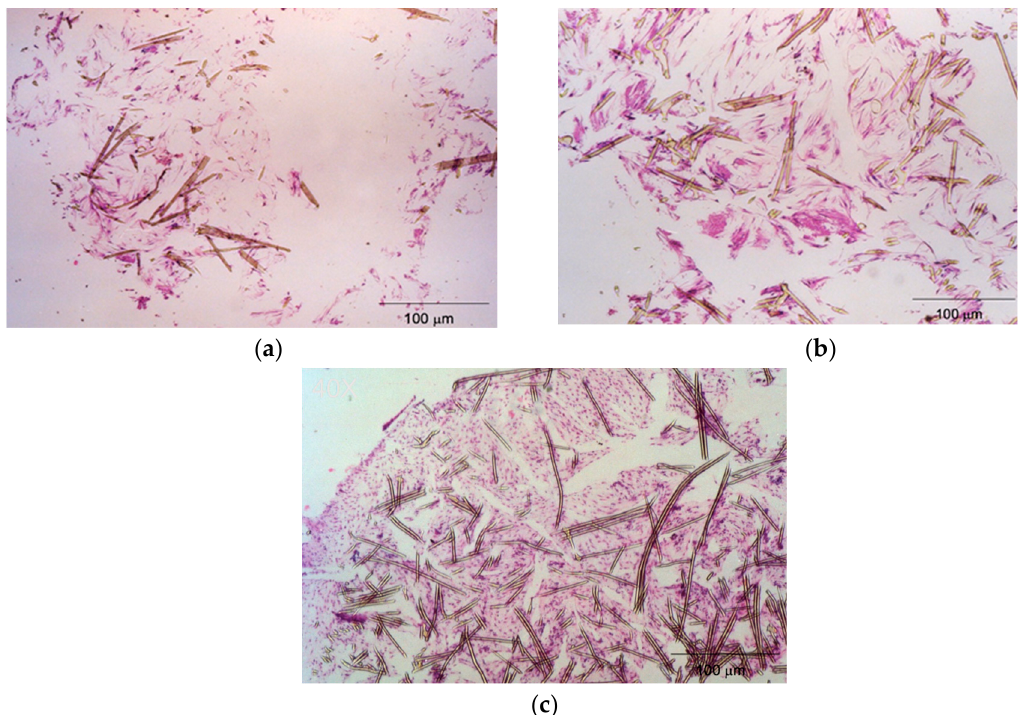
Figure 5. ( a ) The histological study revealed that hMSCs/fiber disk cultured under the static-state culture had a low cell number, non-uniform cell distribution, and few extracellular matrix depositions; ( b ) the spinner flask improved cell distribution while the cell proliferation and matrix deposition were unchanged; ( c ) in addition to a uniform cell distribution, the flow reactor improved cell proliferation and extracellular matrix production dramatically (scale bar, 100 μ m).